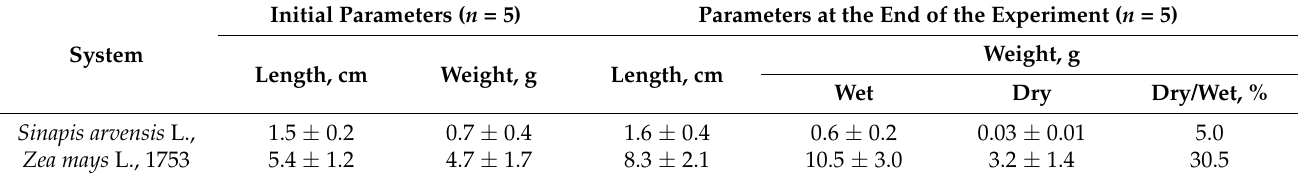
Table 1. Dynamics of changes in the plant parameters [44].